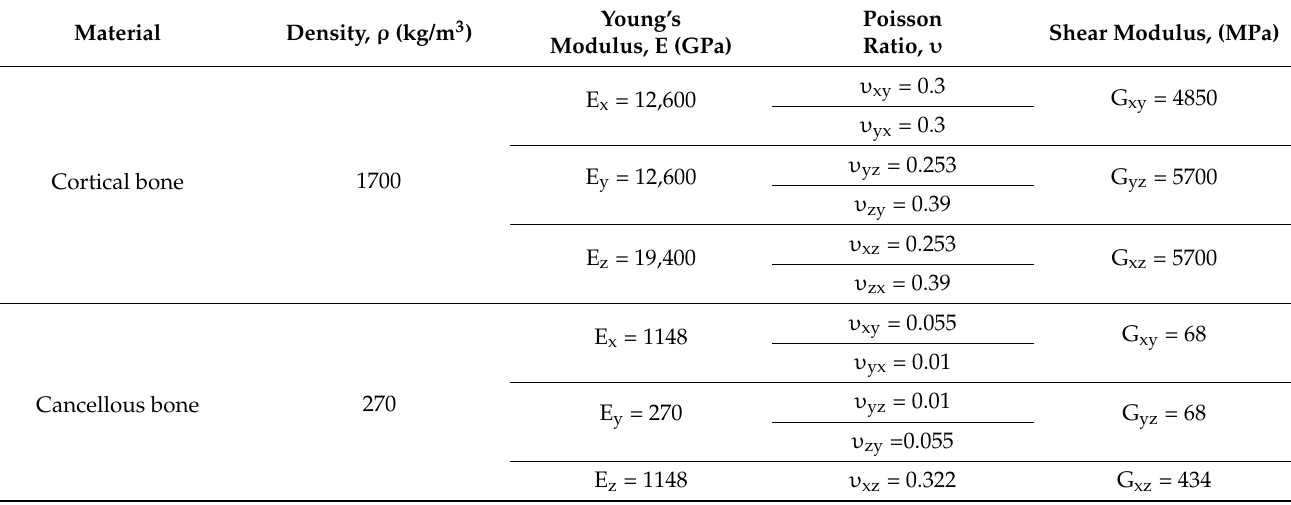
Table 2. Mechanical properties of the bones